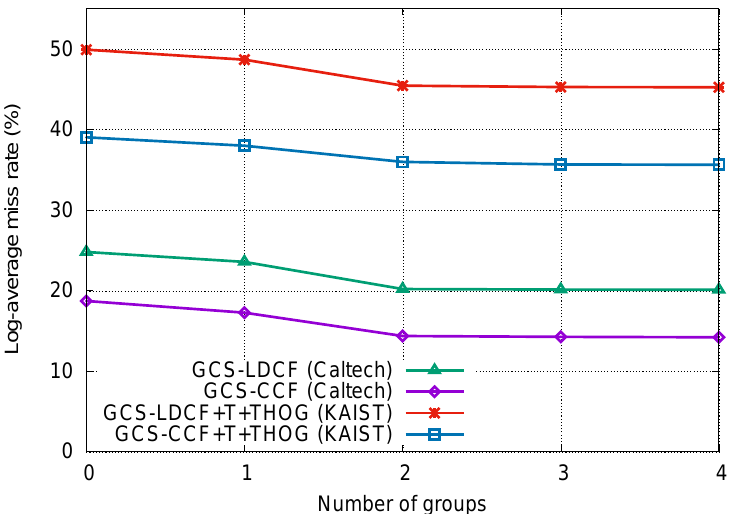
Figure 5. Influence of group number in GCS-LDCF and GCS-CCF on the Caltech and KAIST benchmarks,